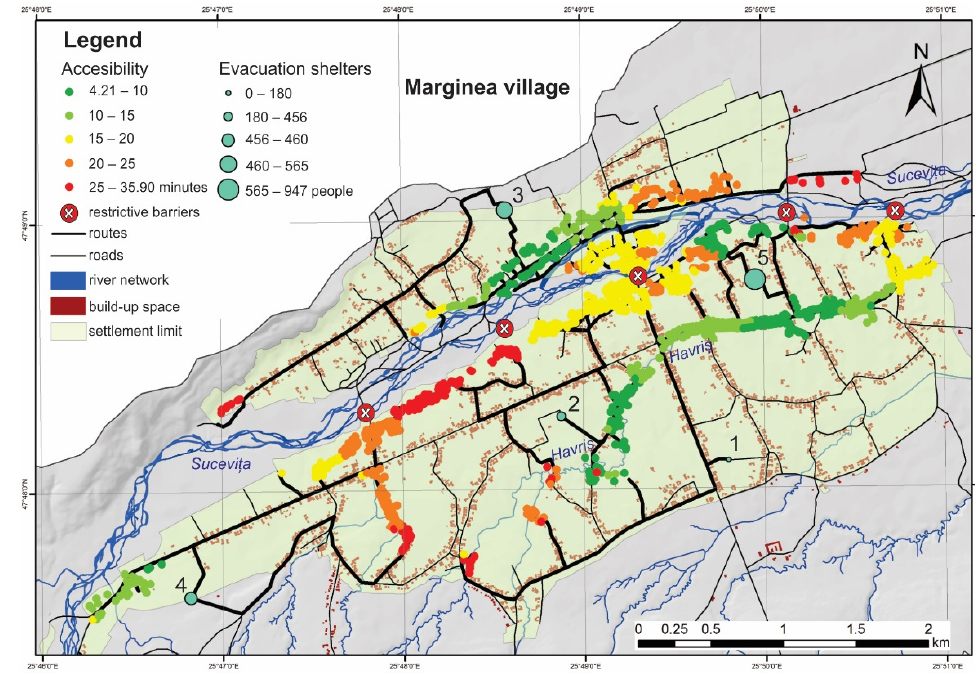
Figure 10. Optimal evacuation routes and accessibility of the population for Marginea village. Table 4. Summary table on the time required to travel distances to evacuation areas for Marginea village. Time to Travel the Distance (Minutes) Number of Persons Dwellings